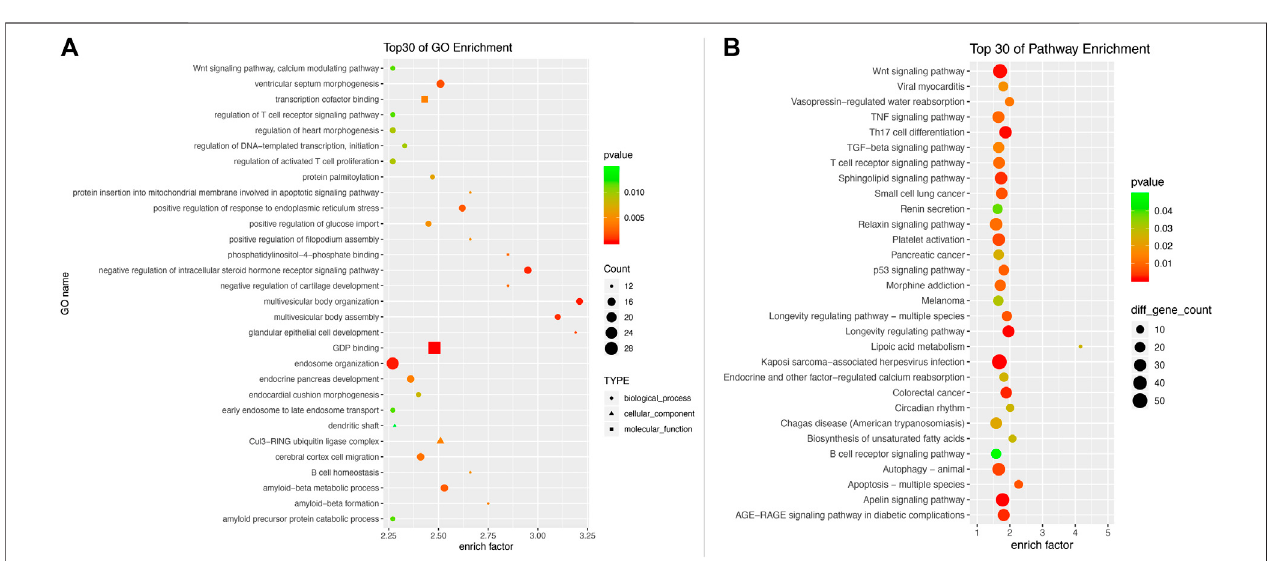
FIGURE 6 | Gene ontology analysis (A) and KEGG Pathway analysis (B) of 3,728 differentially expressed mRNAs. The associated biological processes and signal pathwayswerescreenedaccordingtothecriteria( p value ≤ 0.05,numberoftargetgenes ≥ 10)andsequencedaccordingtotheenrichmentdegree.Thetop30biological processes and signal pathways are demonstrated. Both the GO and KEGG analysis suggested that the Wnt signaling pathway may be involved in the pathogenesis of MMD.